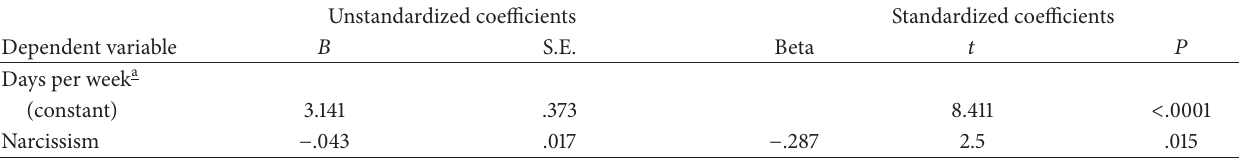
Table 4: Stepwise regression analysis, Model 1. Excluded variables: Authority, Superiority, Exploitativeness, and Self-esteem.